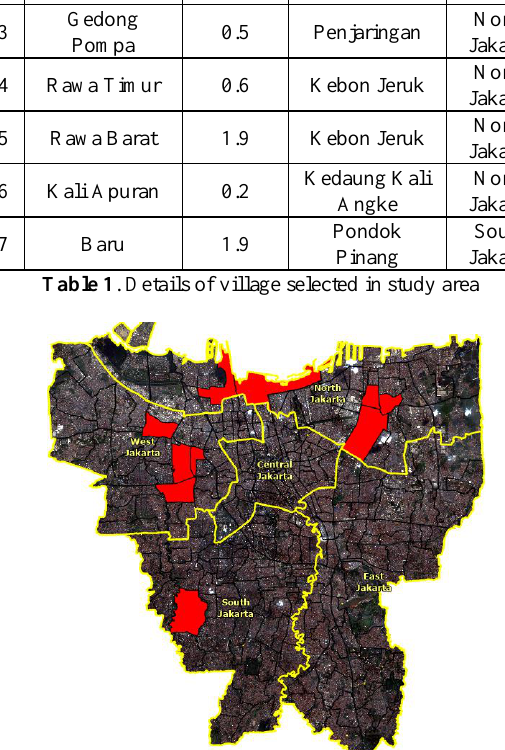
Figure 2 . The location of urban villages (shown in red polygon) where the selected villages located in this